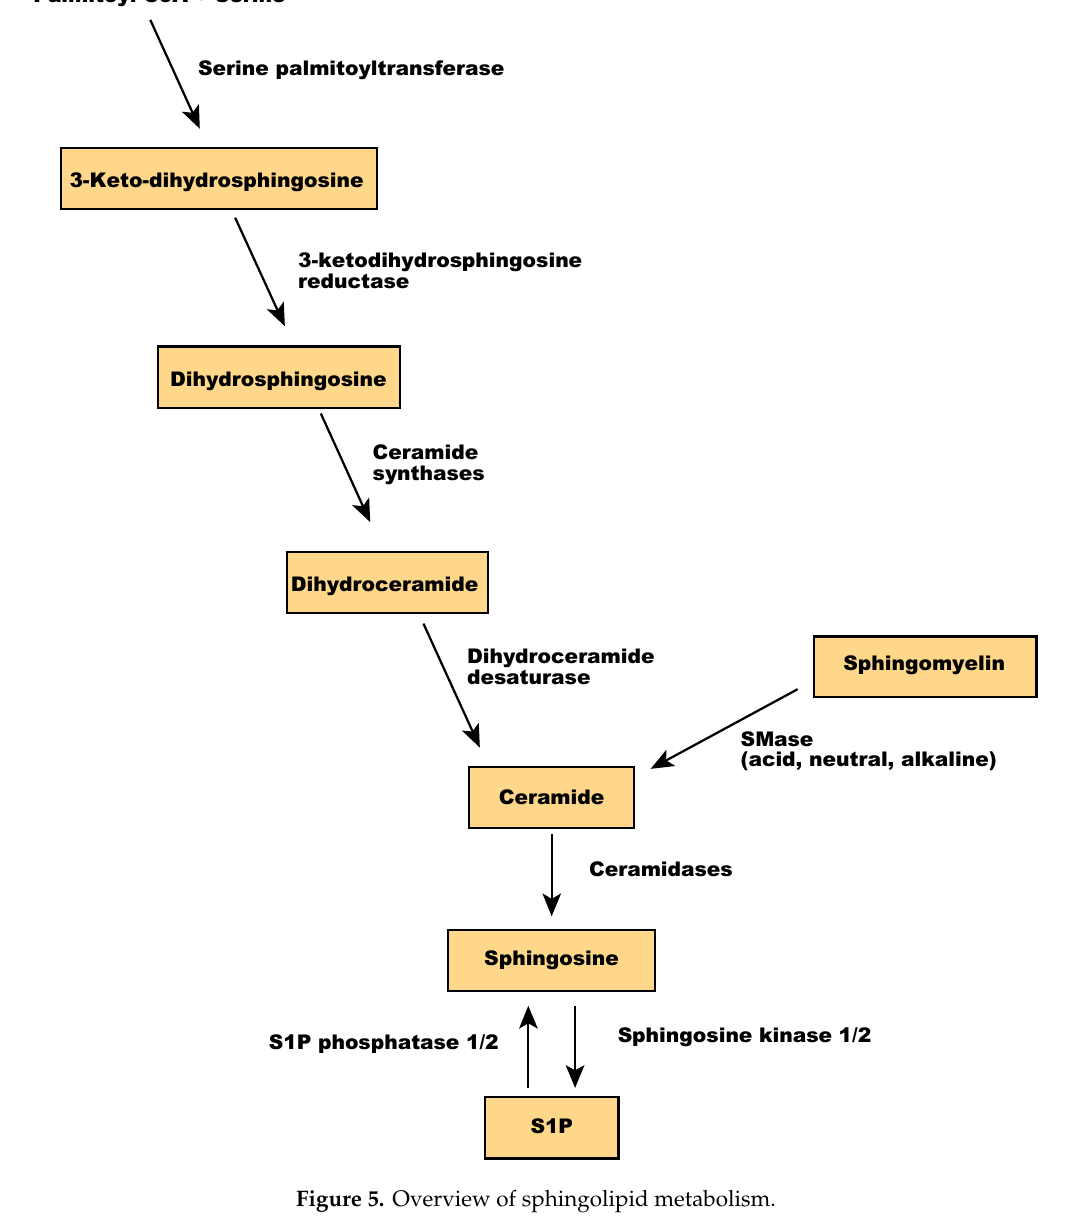
Figure 5. Overview of sphingolipid metabolism.